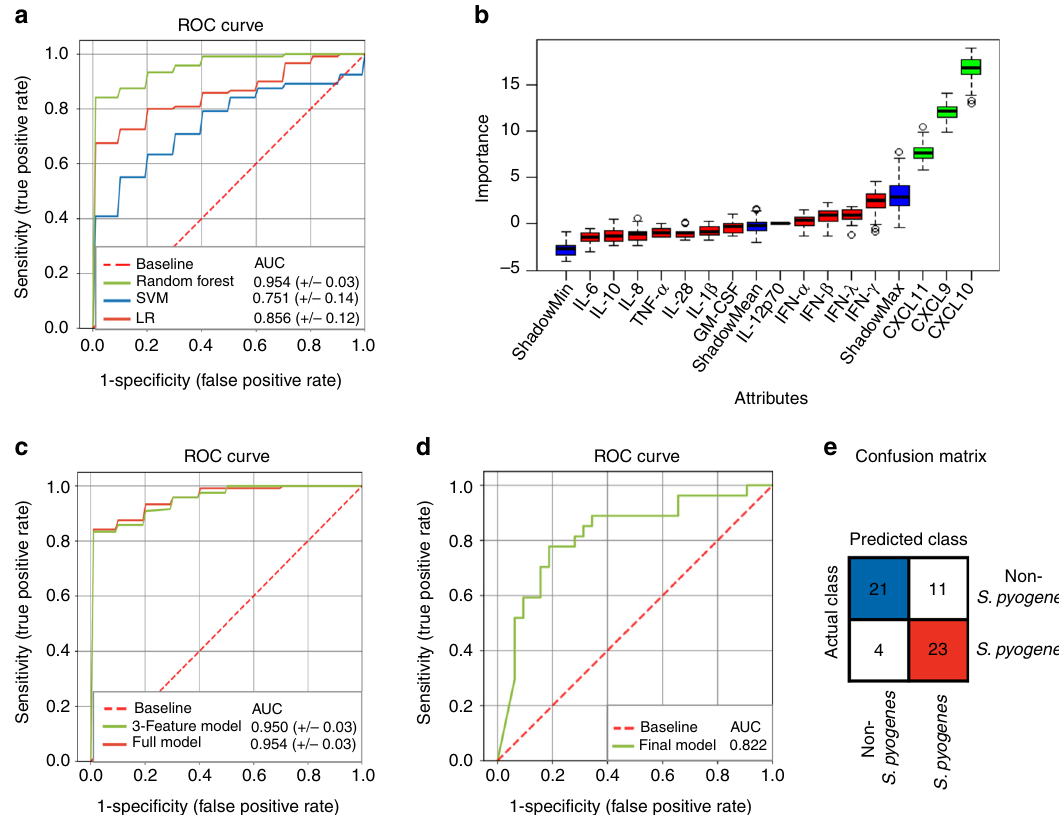
Fig. 7 Identi fi cation of potential plasma biomarkers for microbial diagnosis of NSTIs. a ROC curves for the model comparison of Random Forest (RF, green), linear support vector machine (SVM, blue) and logistic regression (LR, red) on the training cohort ( n = 12 S. pyogenes NSTIs, n = 22 non- S . pyogenes NSTIs) using the full panel of available measured variables. AUC values± 95% CI are given. b Selection of relevant plasma markers for discrimination between S. pyogenes and non- S. pyogenes NSTIs in the training cohort using the Boruta algorithm. Boxplots of features are sorted by increasing importance according to the Z-scores. Features colored in green are those which were classi fi ed as relevant (exhibiting Z-scores higher than shadowMax). Features colored in red are unimportant for model performance. The blue boxes correspond to minimal (shadowMin), mean (shadowMean) and maximal (shadowMax) importance calculated from randomly permuted features. c ROC curves for a RF classi fi er trained on the full panel of features (red) and a 3-feature model trained solely on CXCL9, CXCL 10, and CXCL 11 (green) of the training dataset. AUC values ± 95% CI are given. d ROC curve showing the 3-feature RF classi fi er performance in the independent validation cohort ( n = 27 S. pyogenes NSTIs, n = 32 non- S . pyogenes NSTIs). e Confusion matrix summarizing the performance of the 3-feature model in the independent validation cohort. Each row of the confusion matrix shows the number of samples in an actual class while each column shows the number of samples in a predicted class. Tiles showing the number of correctly classi fi ed cases are colored blue (non- S . pyogenes ) or red ( S. pyogenes ). Source data are available as a source data fi